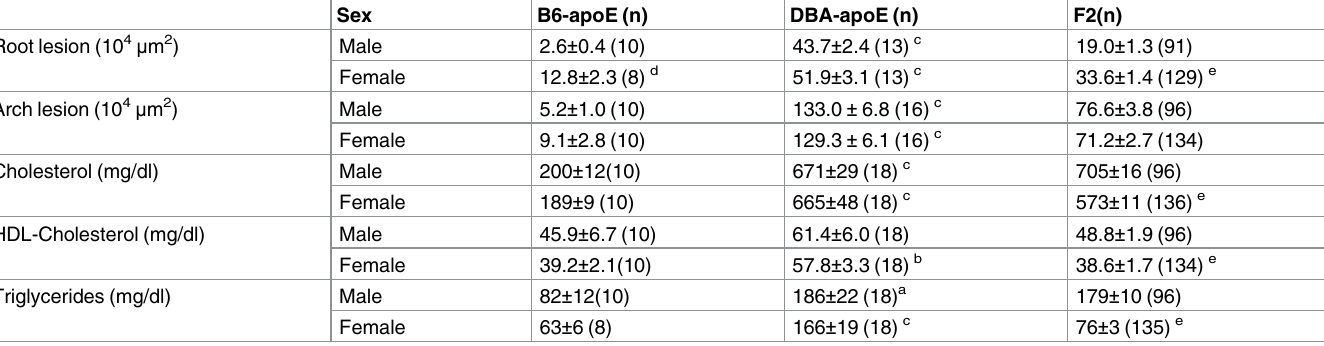
Table 1. Atherosclerotic lesion sizes and plasma lipid levels in the parental mice and F2 from intercross between DBA-apoE and B6-apoE mice.